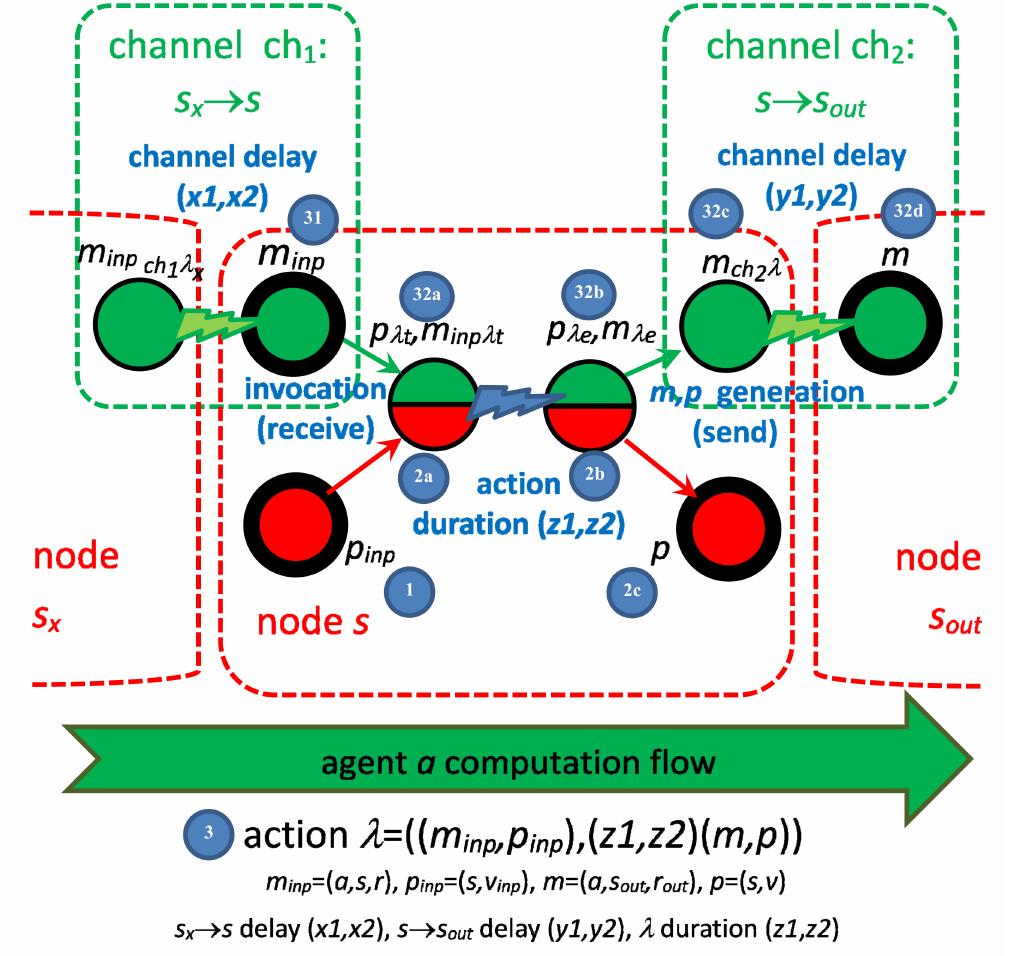
Figure 2. Progress transitions (thin arrows) and timed transitions (thick arrows) in a T-IMDS action occurring in node s and agent a. Elements taking part in the action are surrounded by solid edges, an element of the previous action is surrounded by dashed edges. Every action consists in four steps: message receiving (acceptance and invoking the action), action in progress (time duration), new items generation (message and state), and message delivery (channel time